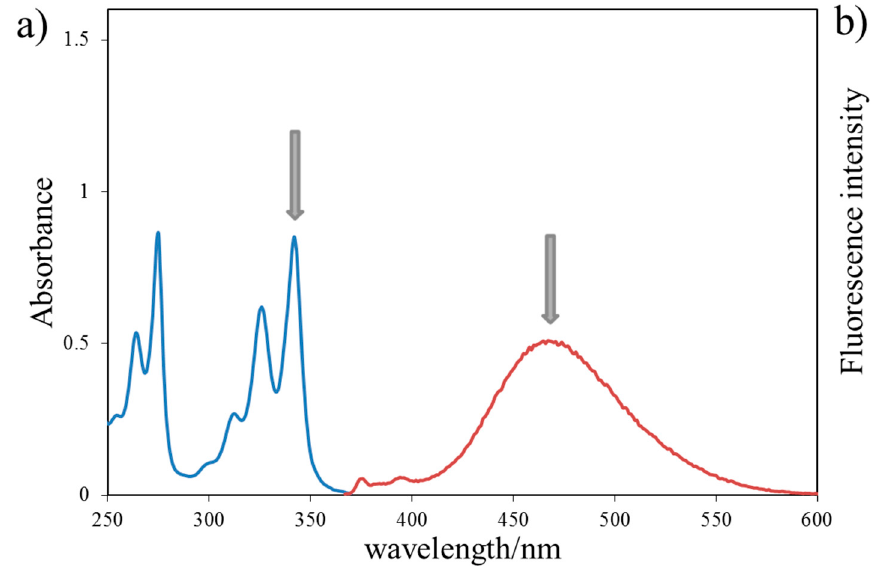
Figure 1. ( a ) UV absorption (blue line) and ( b ) Fluorescence spectra (red line) of bispyrenyl malonate 1 (10 μ M) in acetonitrile/chloroform (9:1, v / v ) (excitation wavelength: λ ex = 344 nm). (10 µ M) in acetonitrile/chloroform (9:1, v / v ) (excitation wavelength: λ